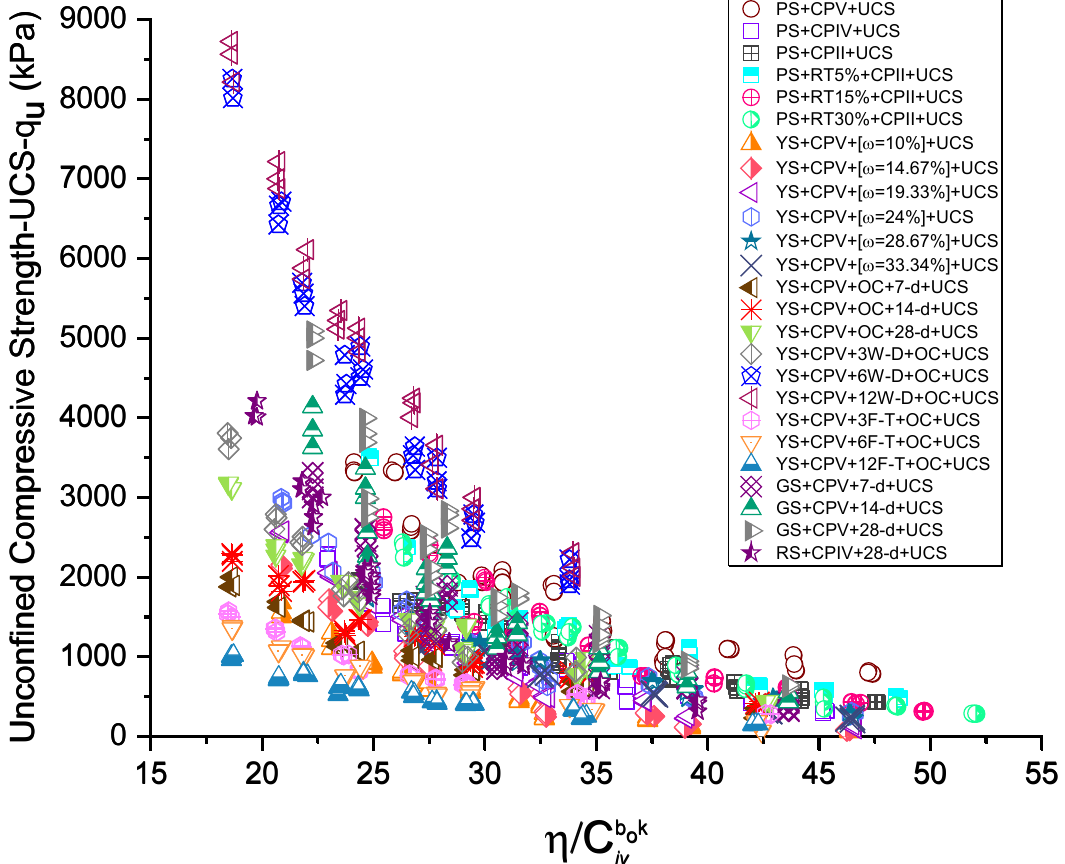
Figure 5. Influence of porosity/volumetric cement index, adjusted at b o = 0.174 and k = 2.565, on unconfined compressive strength for several types of sedimentary silts stabilized with distinct cements and molded in several conditions of moisture using various curing times.